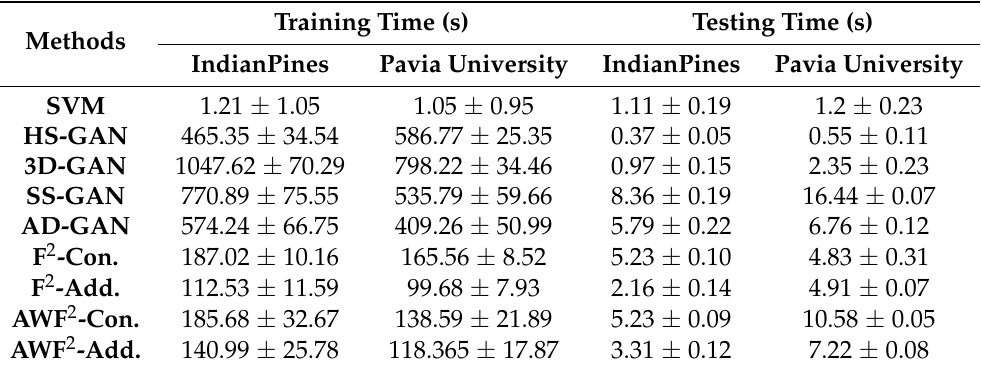
Table 7. Training and testing times of various classification methods on the Indian Pines and Pavia University